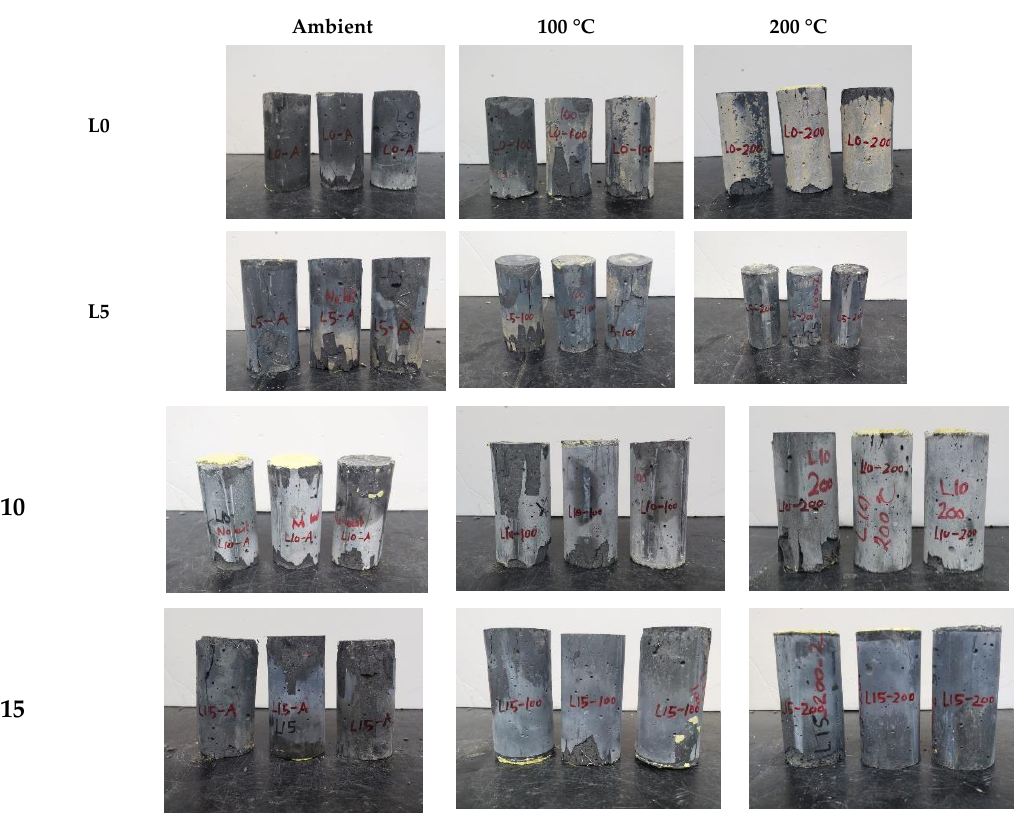
Figure 6. Failure patterns.